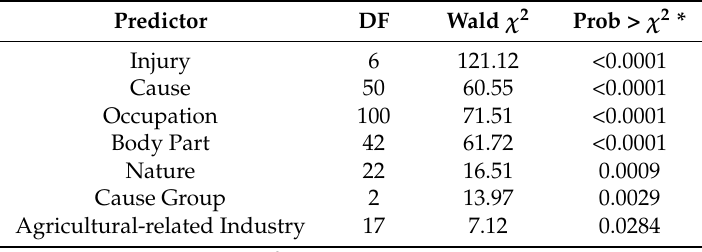
Table 6. Effect test results for the GLM with Weibull distribution using the lasso penalization method.